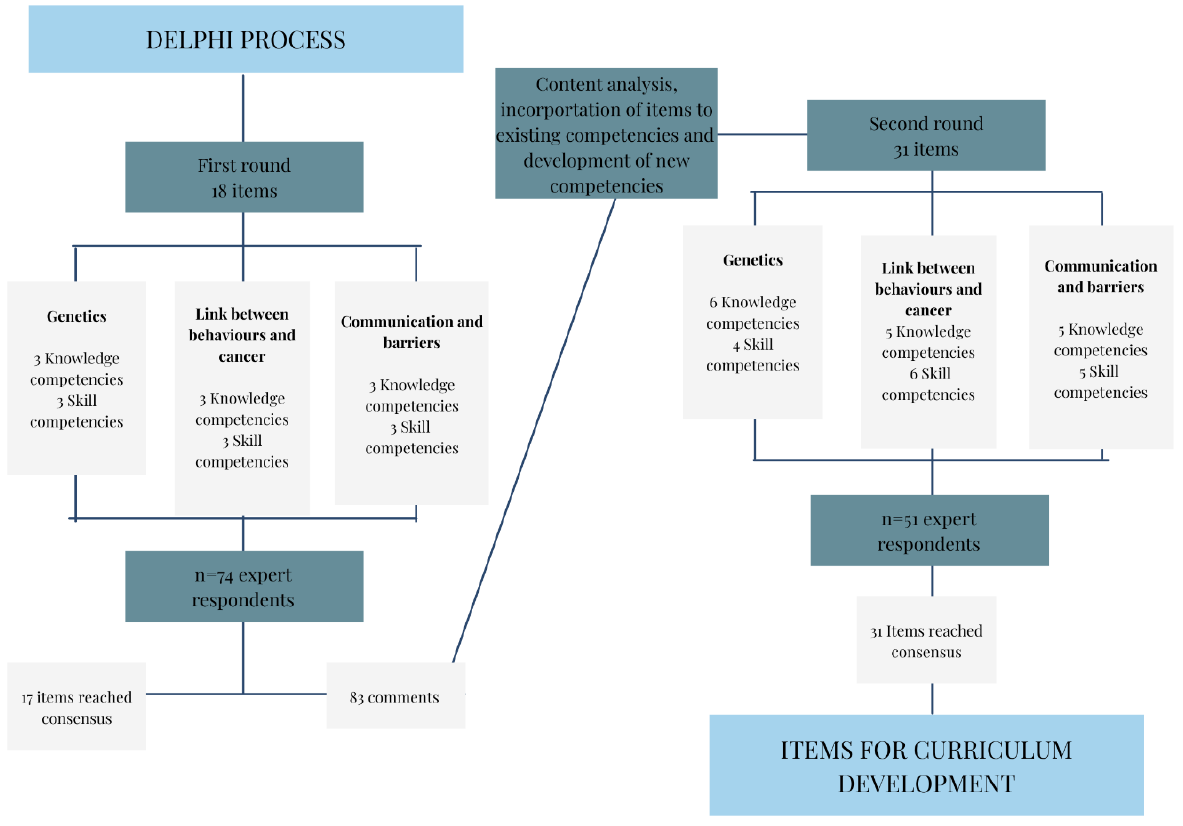
Figure 1. Flow chart of the Delphi process.